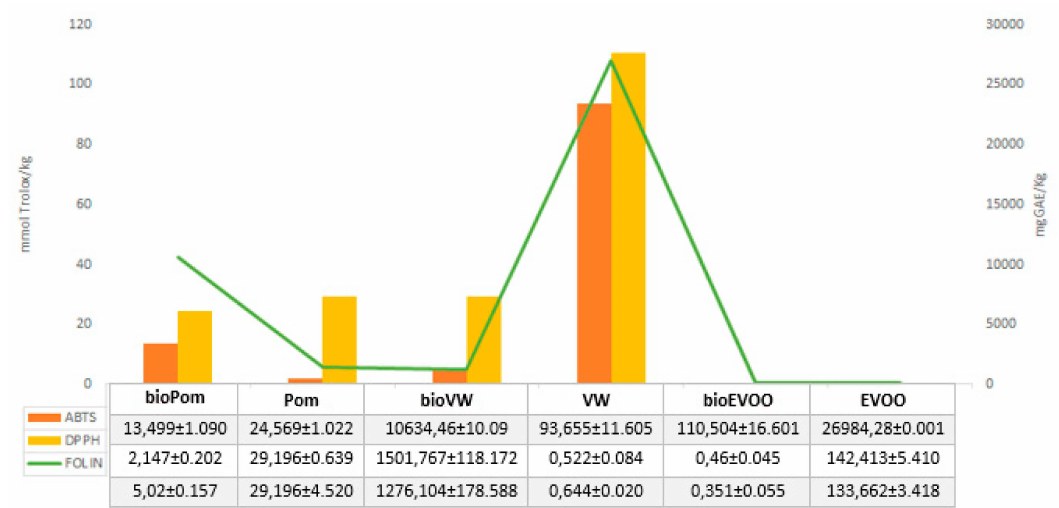
Figure 3. Antioxidant activities (mmol Trolox / kg) and total phenols content (mg GAE / kg)